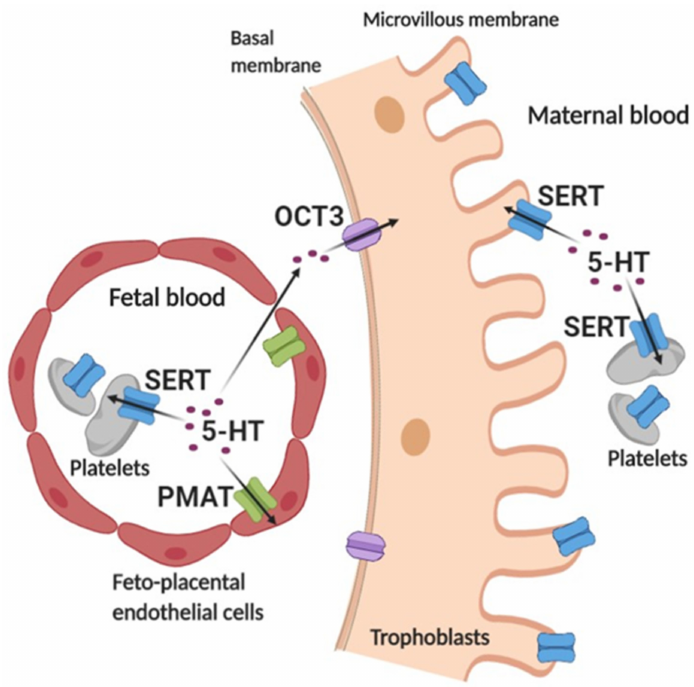
Figure 7. Schematic representation of the cellular uptake of serotonin from the placental extracellular space at the end of human pregnancy based on the literature and current study. Serotonin (5-HT) in fetal plasma is taken up into fetal platelets via the high-affinity serotonin transporter (SERT) and into feto-placental endothelial cells via the low-affinity plasma membrane monoamine transporter (PMAT). In addition, fetal 5-HT can diffuse via paracellular pathways between feto-placental en- dothelial cells and the placental stroma to the basal side of trophoblasts where it serves as a substrate of a low-affinity organic cation transporter 3 (OCT3) [33]. 5-HT in maternal plasma is sequestered via SERT, which is found on both maternal platelets and the apical side of trophoblasts. Created with